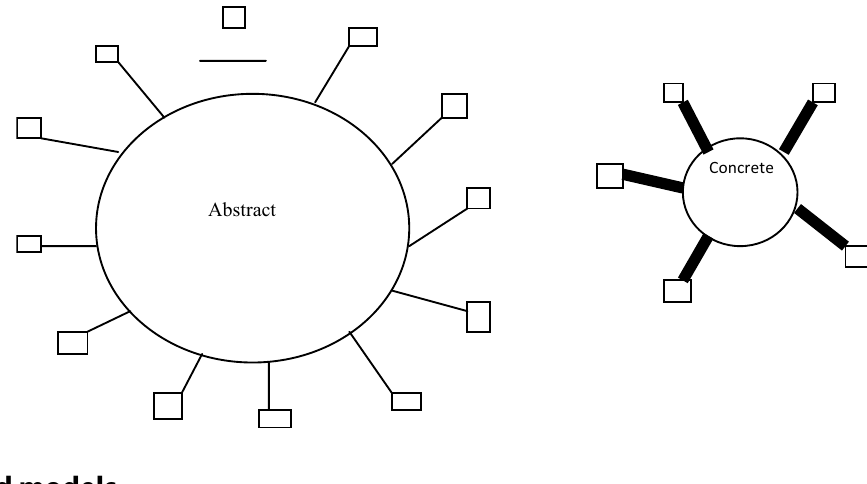
Fig. 1 Difference between abstract and concrete con-